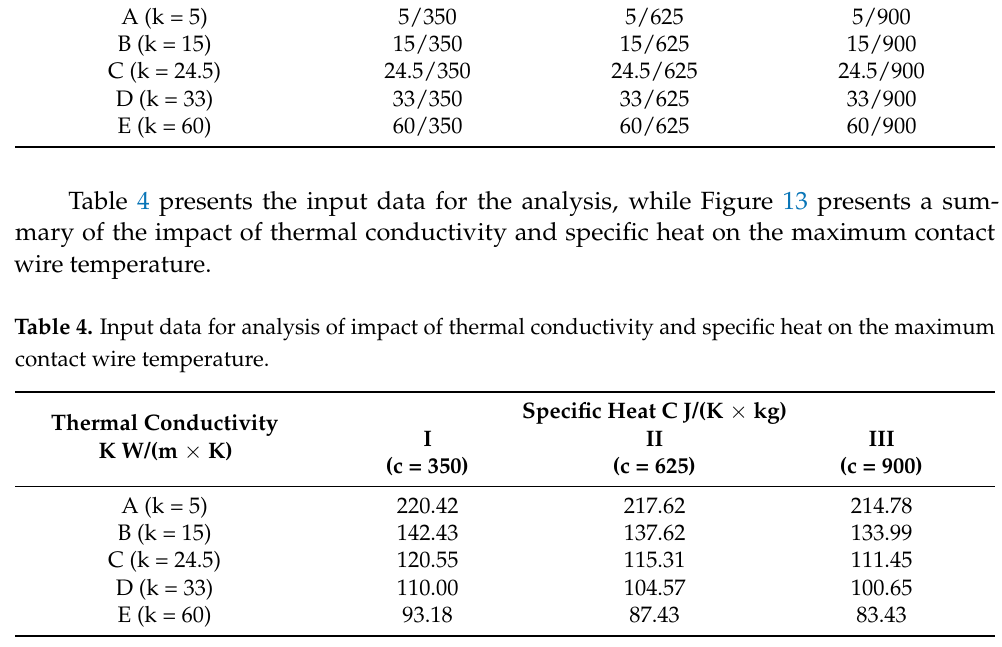
Figure 12. Temperature field in the 3D model cross-section. Table 3. Combinations of simulated values of coefficients reflecting thermal properties. Table 4. Input data for analysis of impact of thermal conductivity and specific heat on the maximum contact wire temperature.